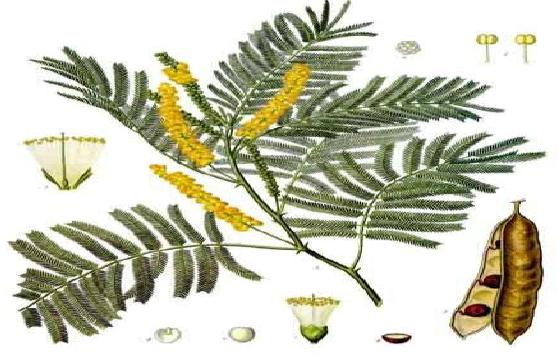
Figure 9. Acacia catech (also called Mimosa catechu)